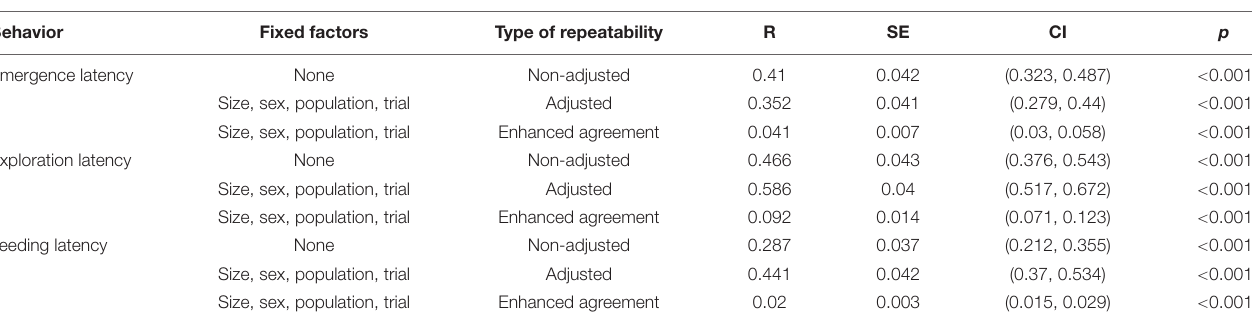
FIGURE 3 | Comparison of decrease in emergence latency (A) , exploration latency (B) , and feeding latency (C) across the training trials (1–8) and then increase in test trials (9 and 10) for Cooch Behar (CB), Kali Bazar (KB), and Leturakhal (LK). Points on graphs represent means across populations and error bars represent the standard error. TABLE 5 | Repeatability for behaviors across populations with Fish ID as random factor.